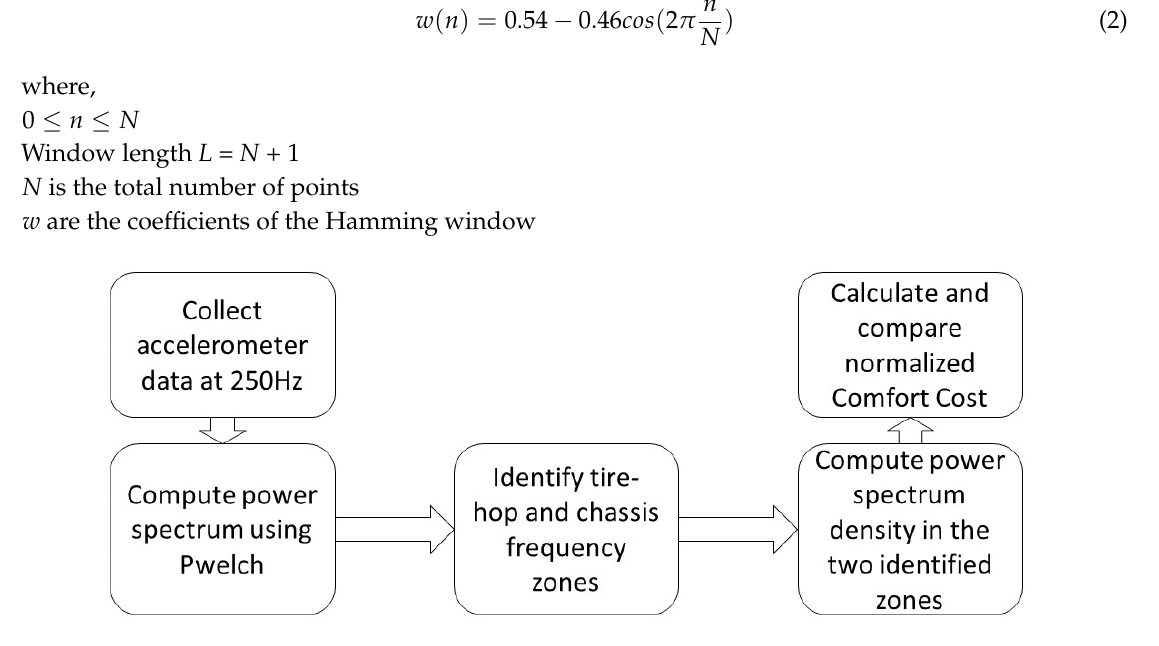
Figure 10. Data processing